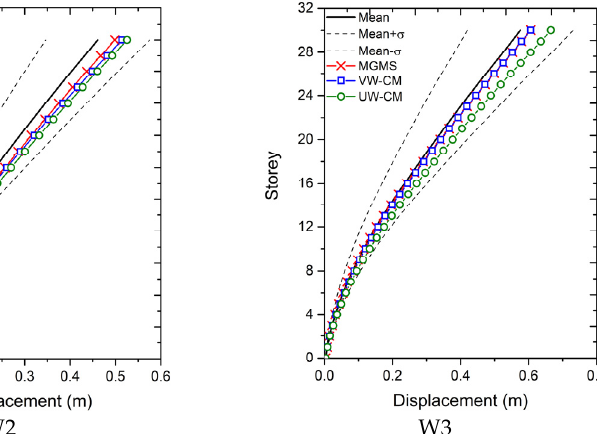
Figure 4. Comparison of the floor displacements of wall structures under motion Set